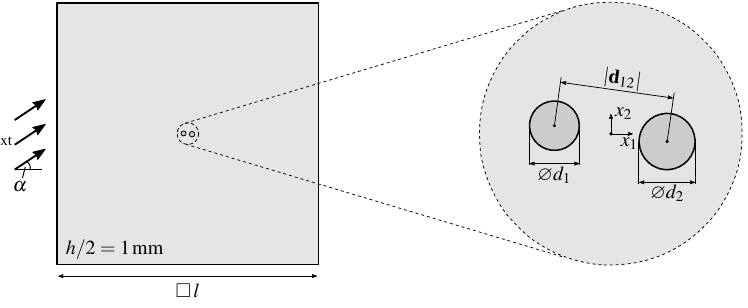
Figure 1. Setup for the proposed benchmark problem: top-view on the center plane of the sample and a magnification of the two magnetizable particles embedded into its center—the global coordinate system is indicated within the magnified area. The problem is symmetric with respect to the depicted x 1 - x 2 -plane and the sample is loaded with an external magnetic field B ext of varying angle α —for the mechanical boundary conditions, see Section